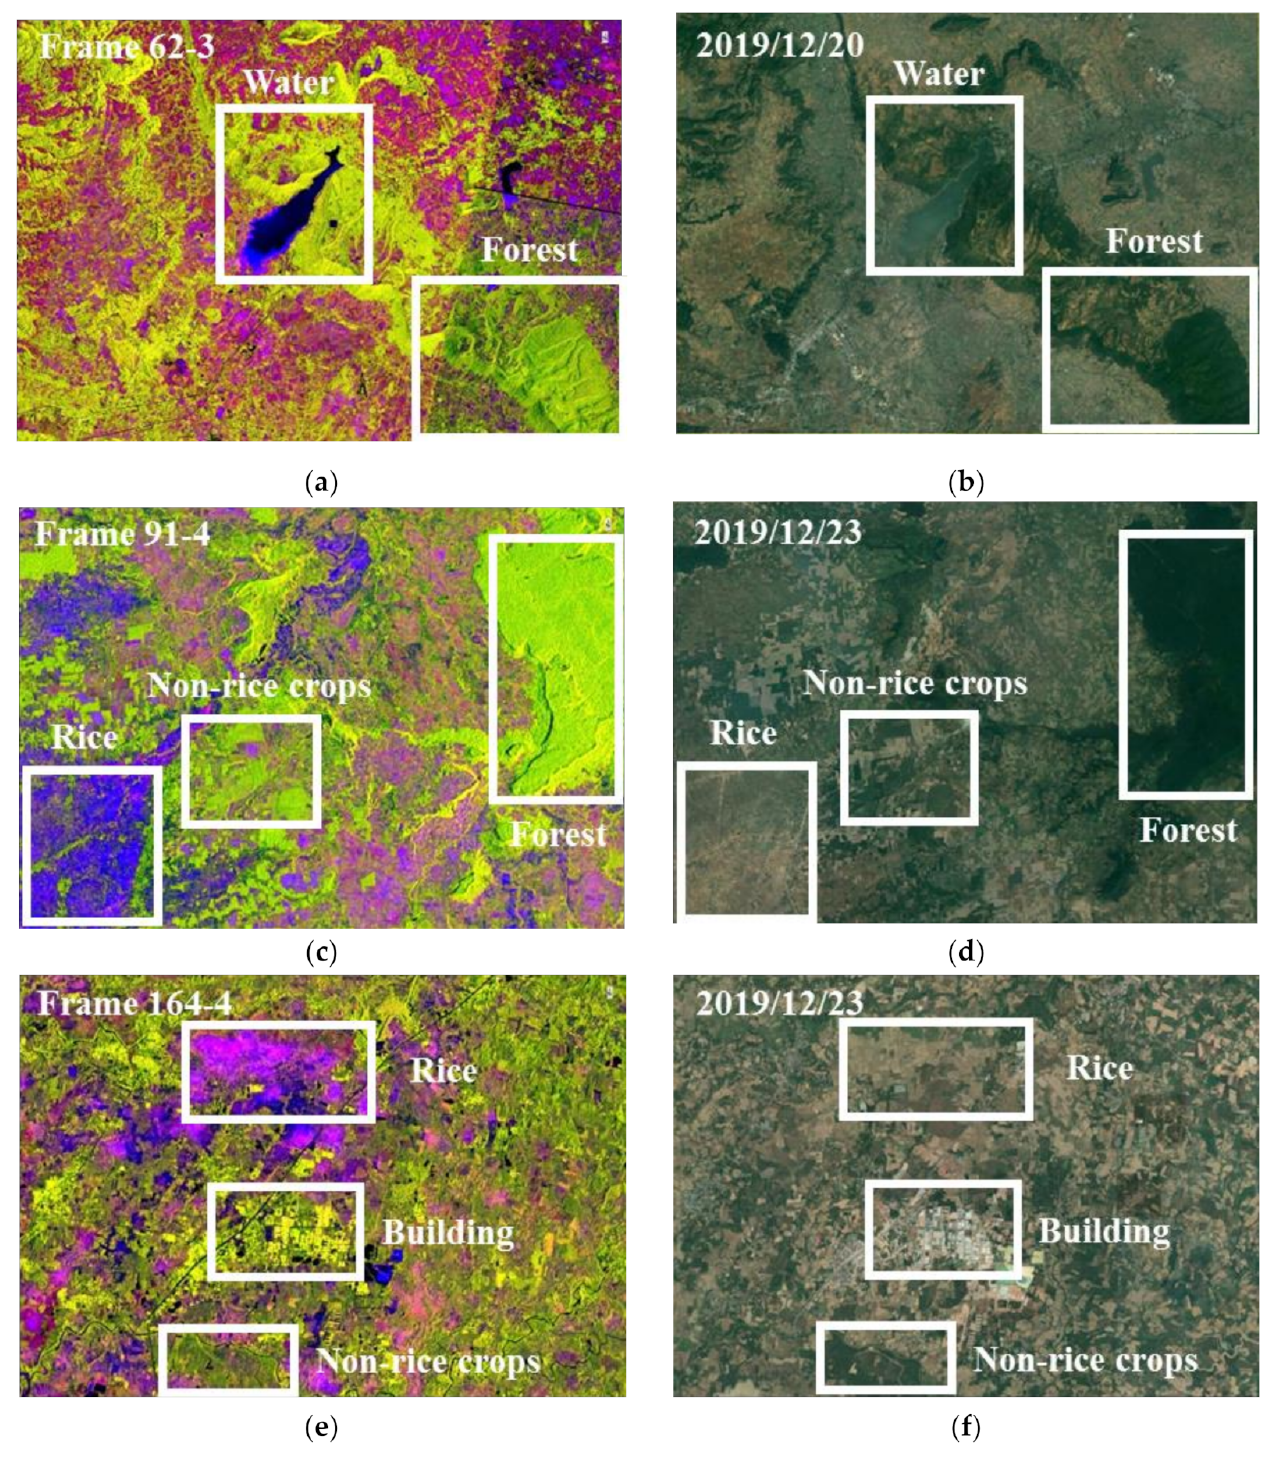
Figure 8. Typical performance of different land covers (water, rice, non-rice crops, building, forest) of VH polarization: ( a , c , e ) the false-color images of three temporal features in three ROIs (R: σ 0 max , G: σ 0 optical images of ROIs ( a , c , e